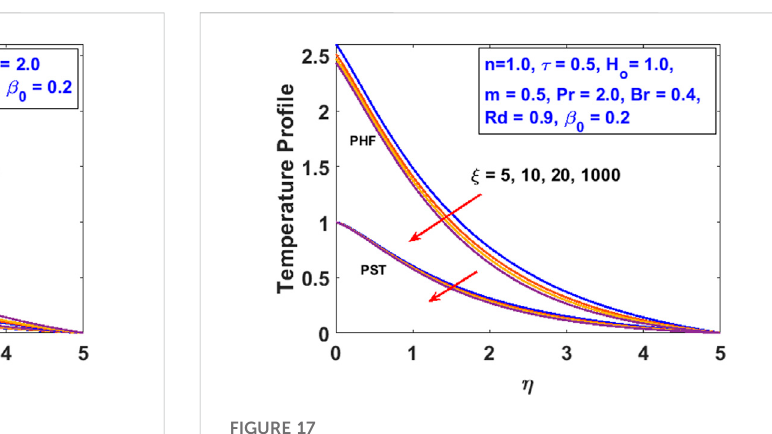
FIGURE 17 Effects of ξ on